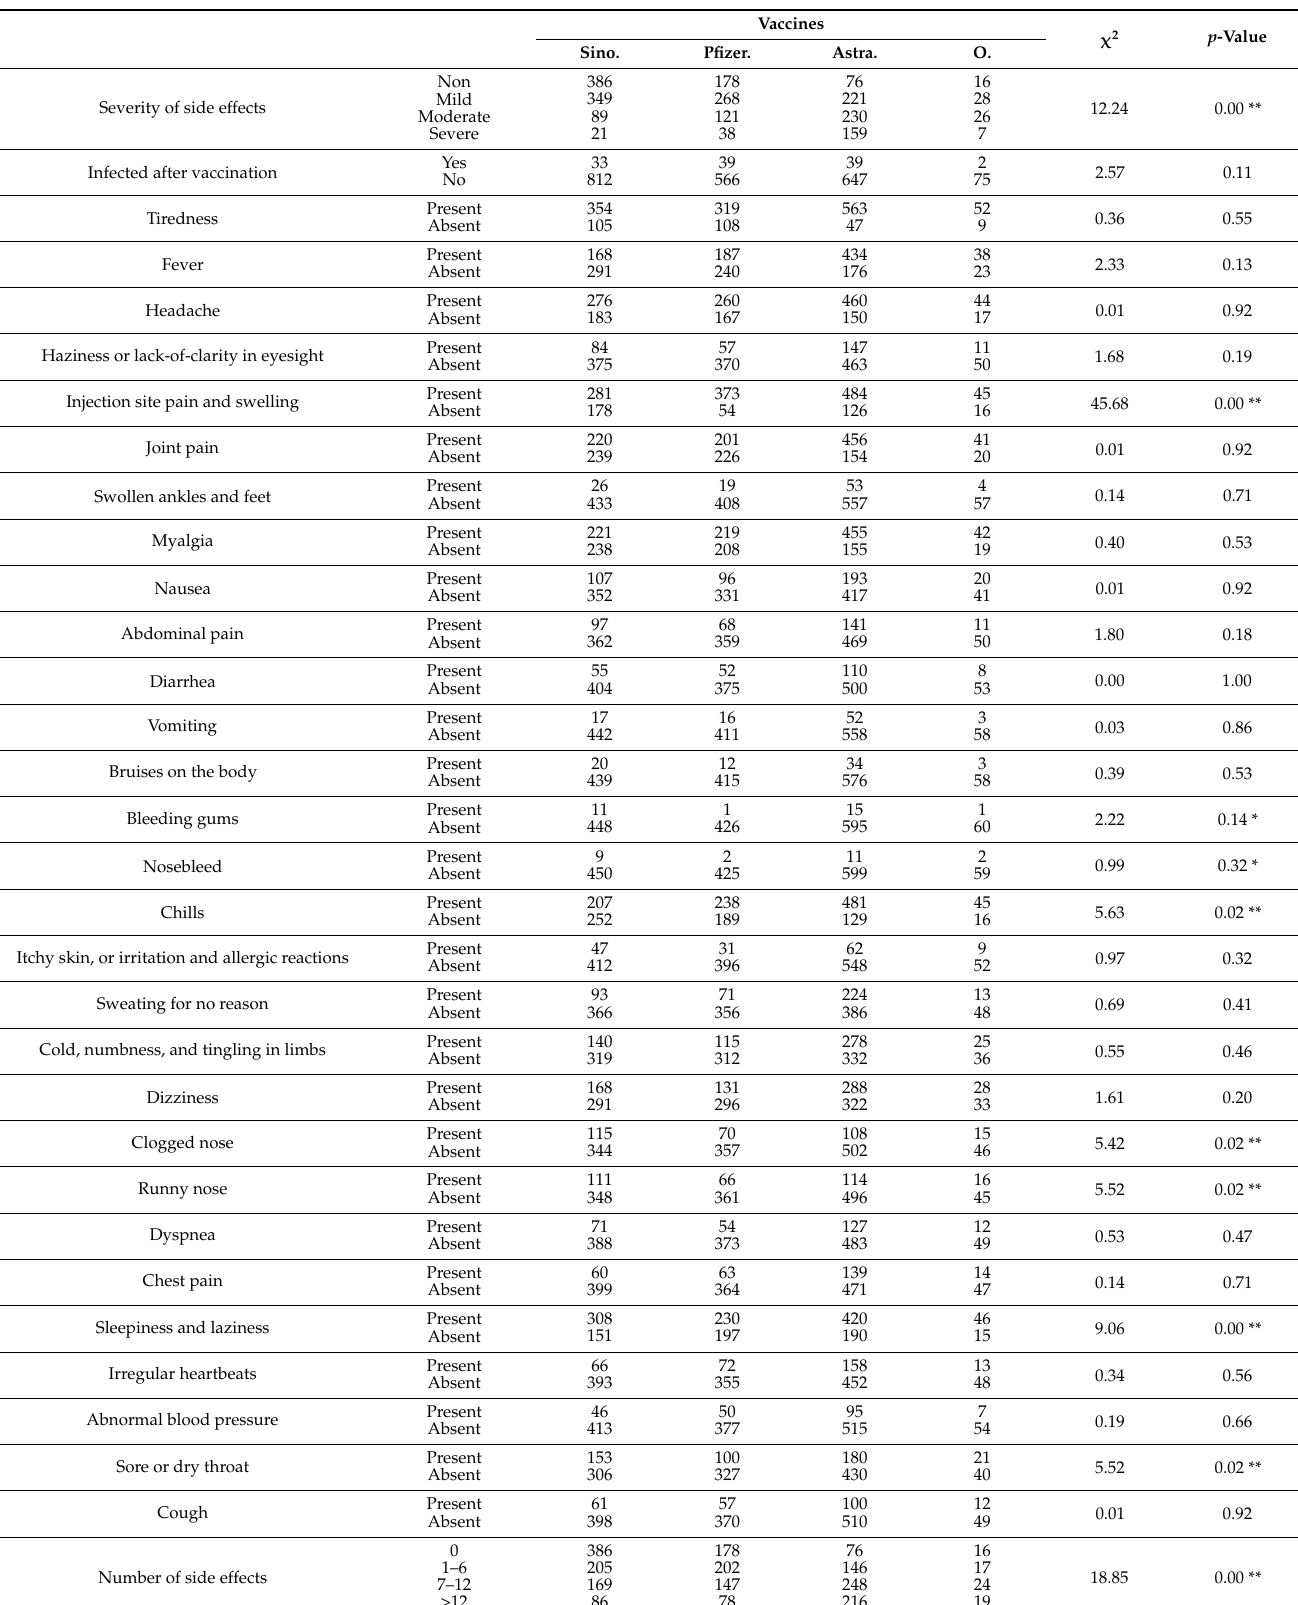
Table 6. Association of each symptom with the types of COVID-19 vaccine. Vaccines χ 2 p -Value Sino. Pfizer. Astra.